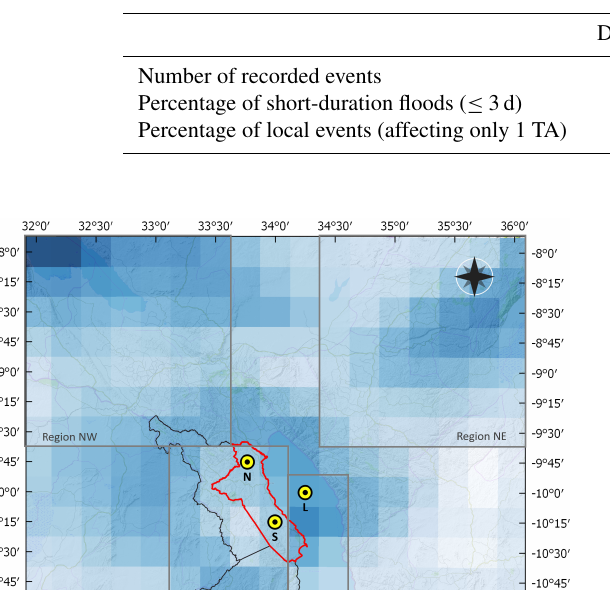
Table 2. Monthly flood event frequency based on 2000–2018 secondary data collection (43 recorded events) and associated proportion of short-duration ( ≤ 3d) and local (affecting only 1 TA) recorded flood events.